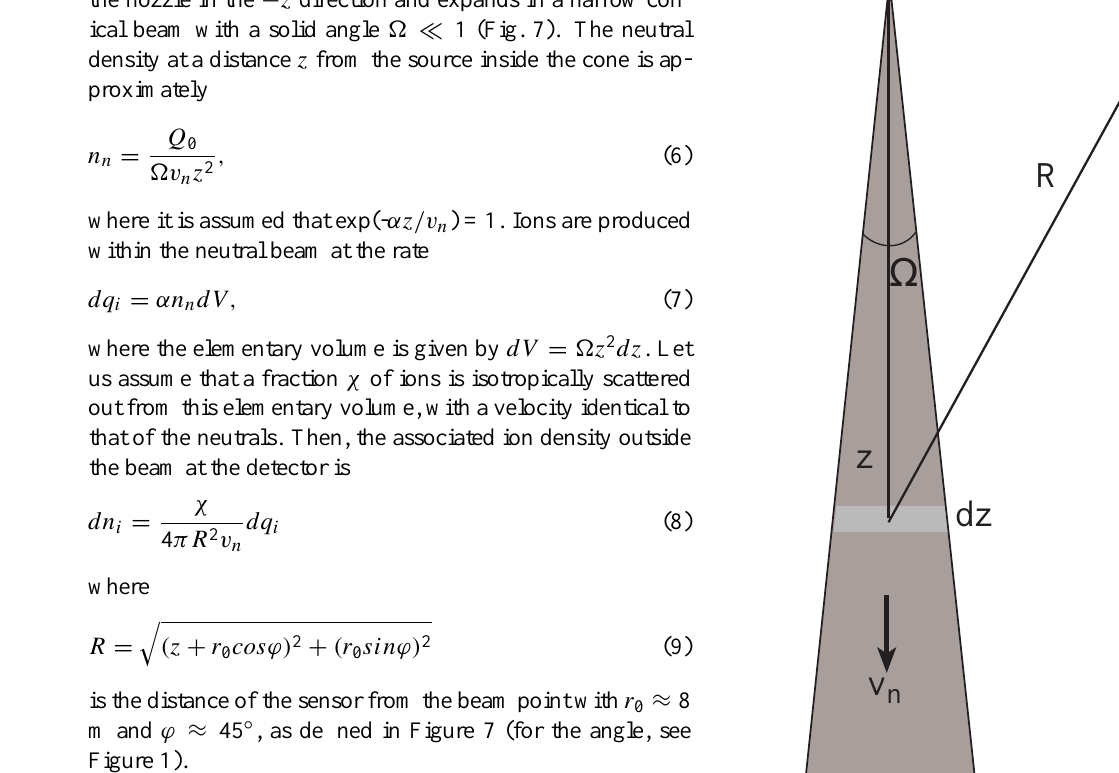
Fig. 7. Schematic representation of the gas release cone; the open- ing solid angle of the release is (cid:127) . The observation point (L2 sen- sor) is at distance r 0 ≈ 8 m from the source of the